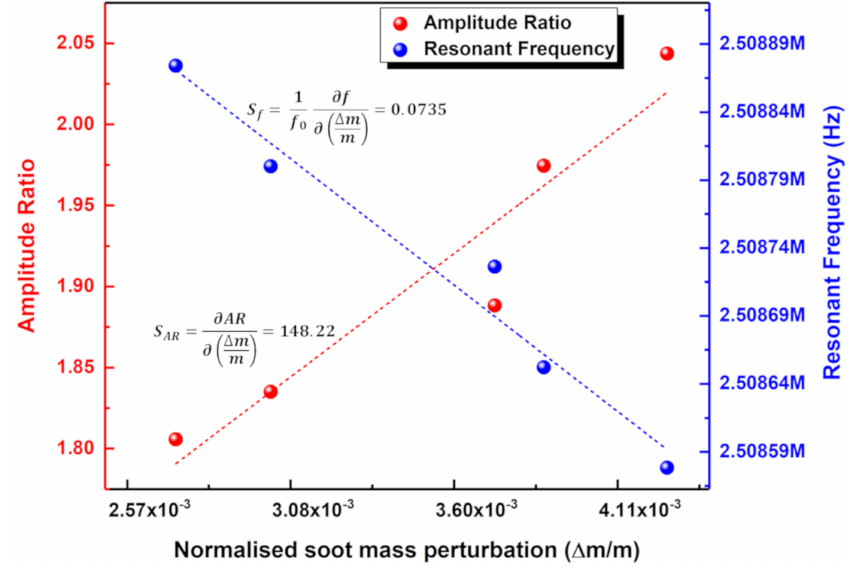
Figure 9. Sensitivity of the coupled MEMS resonators based on amplitude ratio shift and resonant frequency shift for the second 20 min of soot particle impaction on one of the coupled